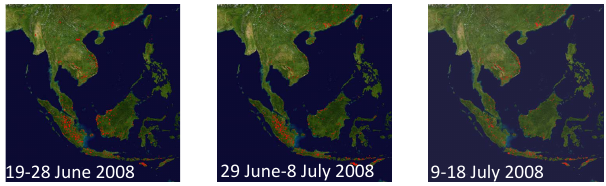
Fig. 4. NASA MODIS fire count distributions from 19 June–18 July 2008 in 10-day intervals